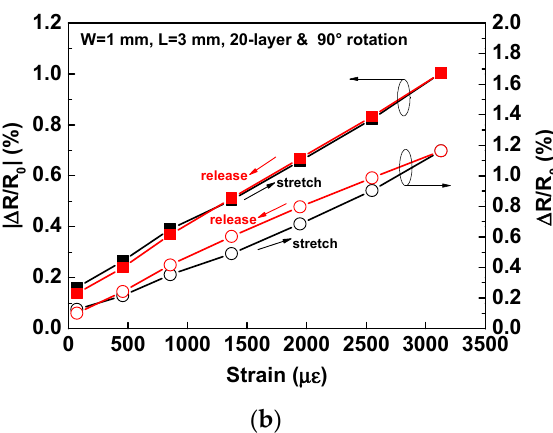
Figure 9. ( a ) Stretch / release transient response as a function of various strains from 71 to 3128 µε for 20-layer strain sensor; ( b ) stretch / release curves of the 20-layer strain sensor.